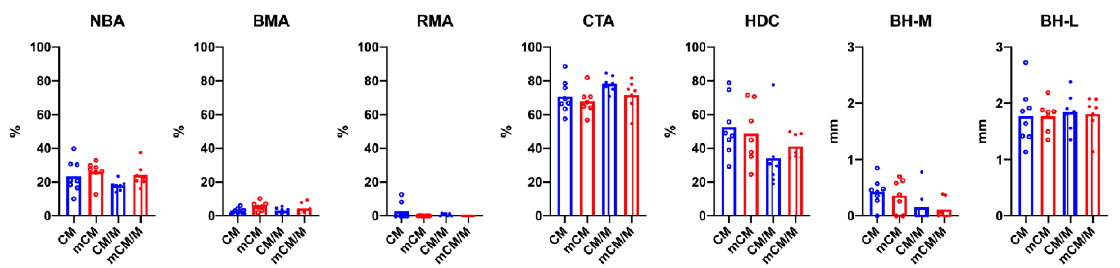
Figure 7. The comparison of histomorphometric results. The mCM group showed highest mean values of NBA and BMA.